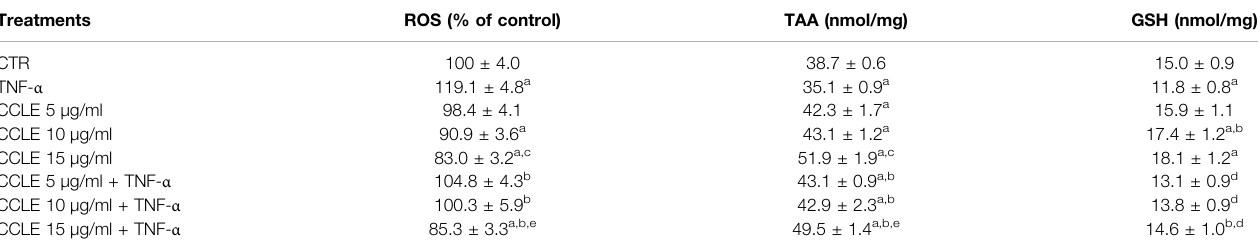
TABLE1| Intracellularredoxstatus.TheCaco-2monolayerwaspretreatedwithCCLE(5-15 μ g/ml)for24 h,andsubsequentlyexposedto50 ng/mlTNF- α for6 h.Cultures treated with the vehicles alone were used as controls (CTR). ROS levels are reported as % DCFH-DA fl uorescence intensity relative to control. Cellular GSH levels and total antioxidant activity (TAA) are reported as nmoles of GSH/mg of proteins and nmoles of trolox equivalents/mg of proteins respectively and expressed as mean ± SD of three independent experiments.